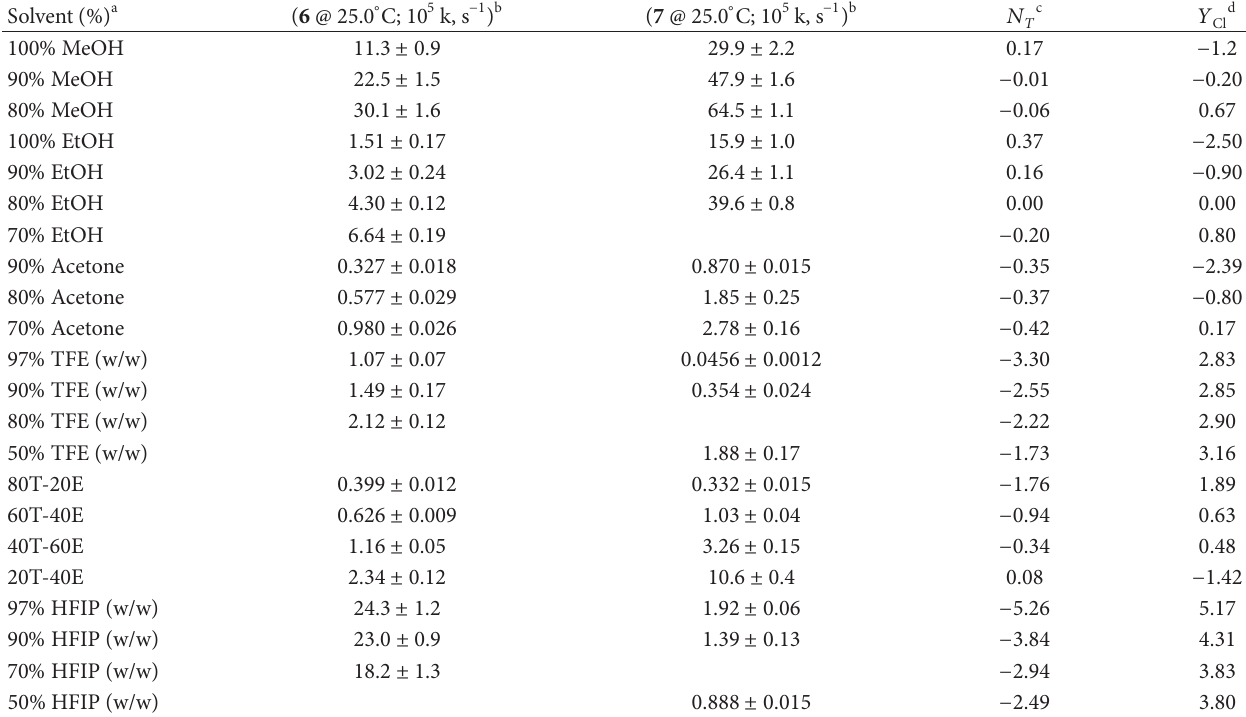
T 1: Speci�c rates of solvolysis ( k ) of 6 and 7 in several binary solvents at 25.0